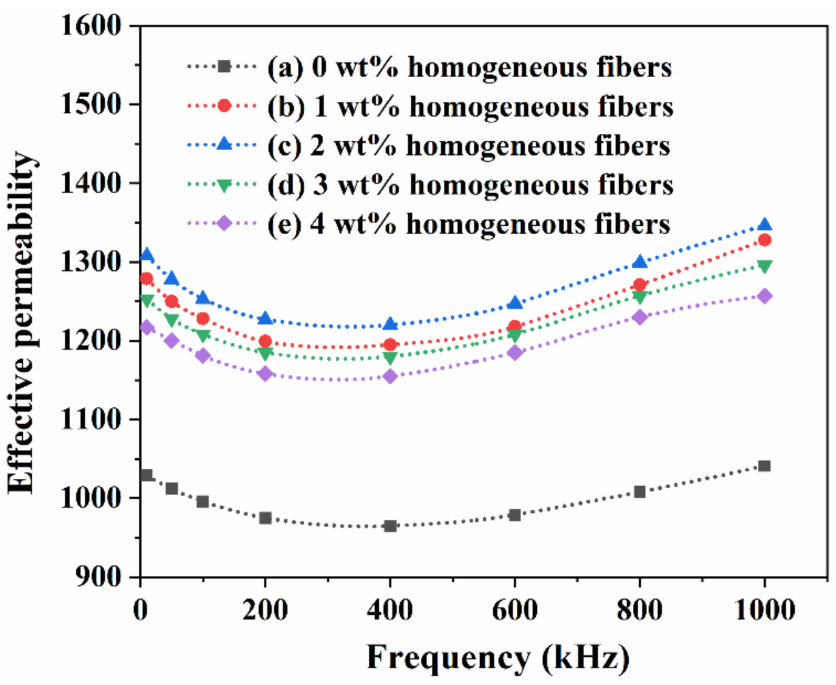
Figure 3. Effective permeability of the homogeneous-fiber-reinforced MnZn ferrite samples versus frequency at room temperature: (a) 0 wt%, (b) 1 wt%, (c) 2 wt%, (d) 3 wt%, and (e) 4